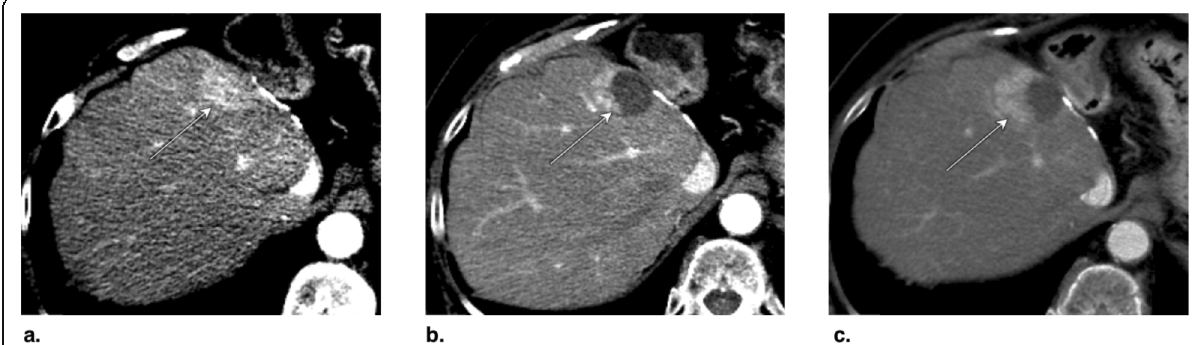
Fig. 16 Axial CT in late arterial phase obtained ( a ) pretreatment: image shows nonrim arterial phase hyperenhancement (APHE) of a 2.8-cm LR-5 observation in segment VIII (arrow) of a patient with prior left hepatectomy. b 6 weeks post microwave ablation (MWA): image shows hypodense cavity with peripheral thick nodular APHE (arrow). c 3 months post MWA: image shows thick nodular APHE (arrow). The treated observation